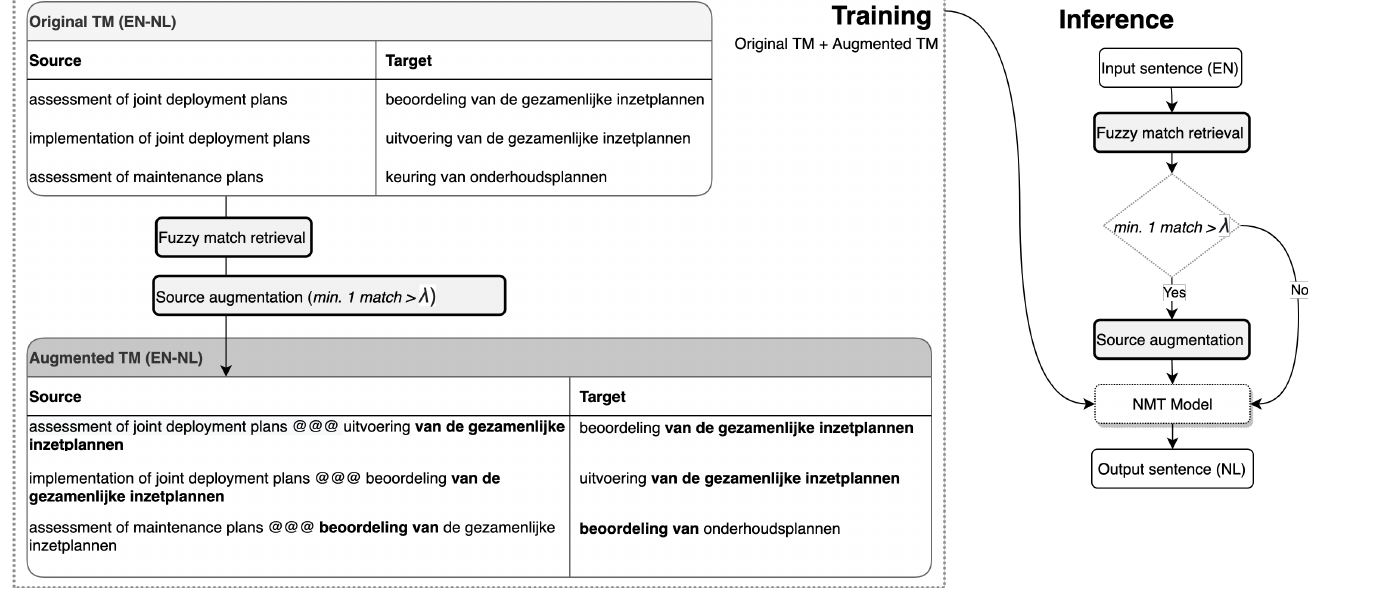
Figure 1. Neural fuzzy repair: training and